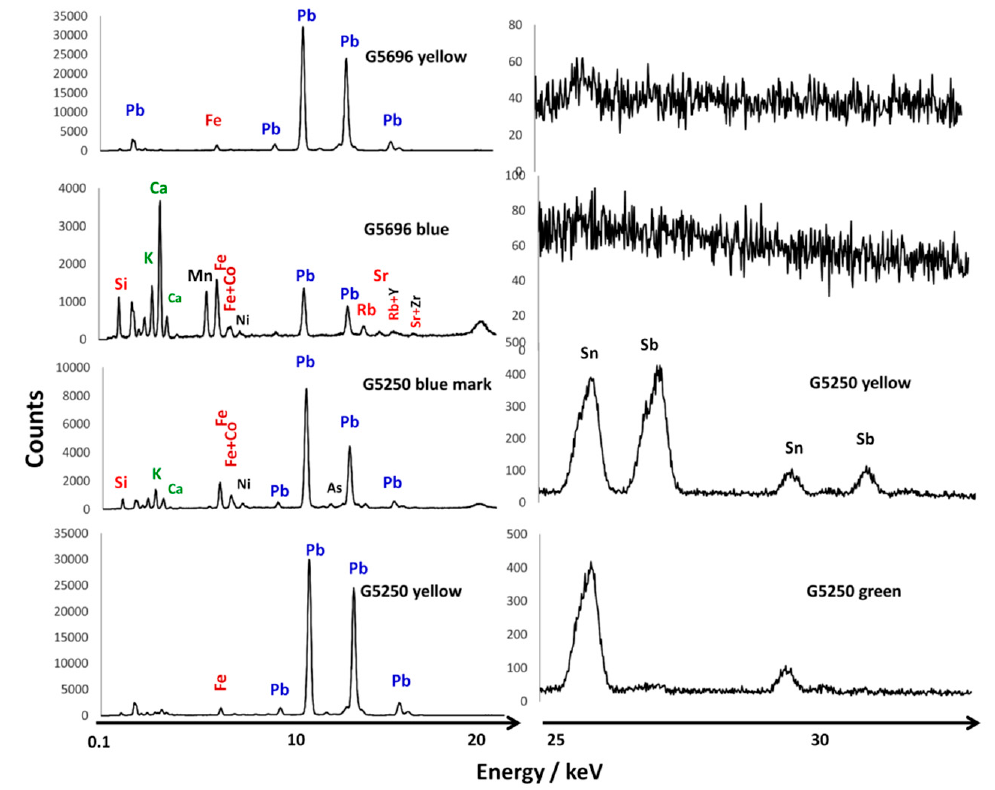
Figure 2. Representative XRF spectra of enameled porcelain (see Table 1 for details).